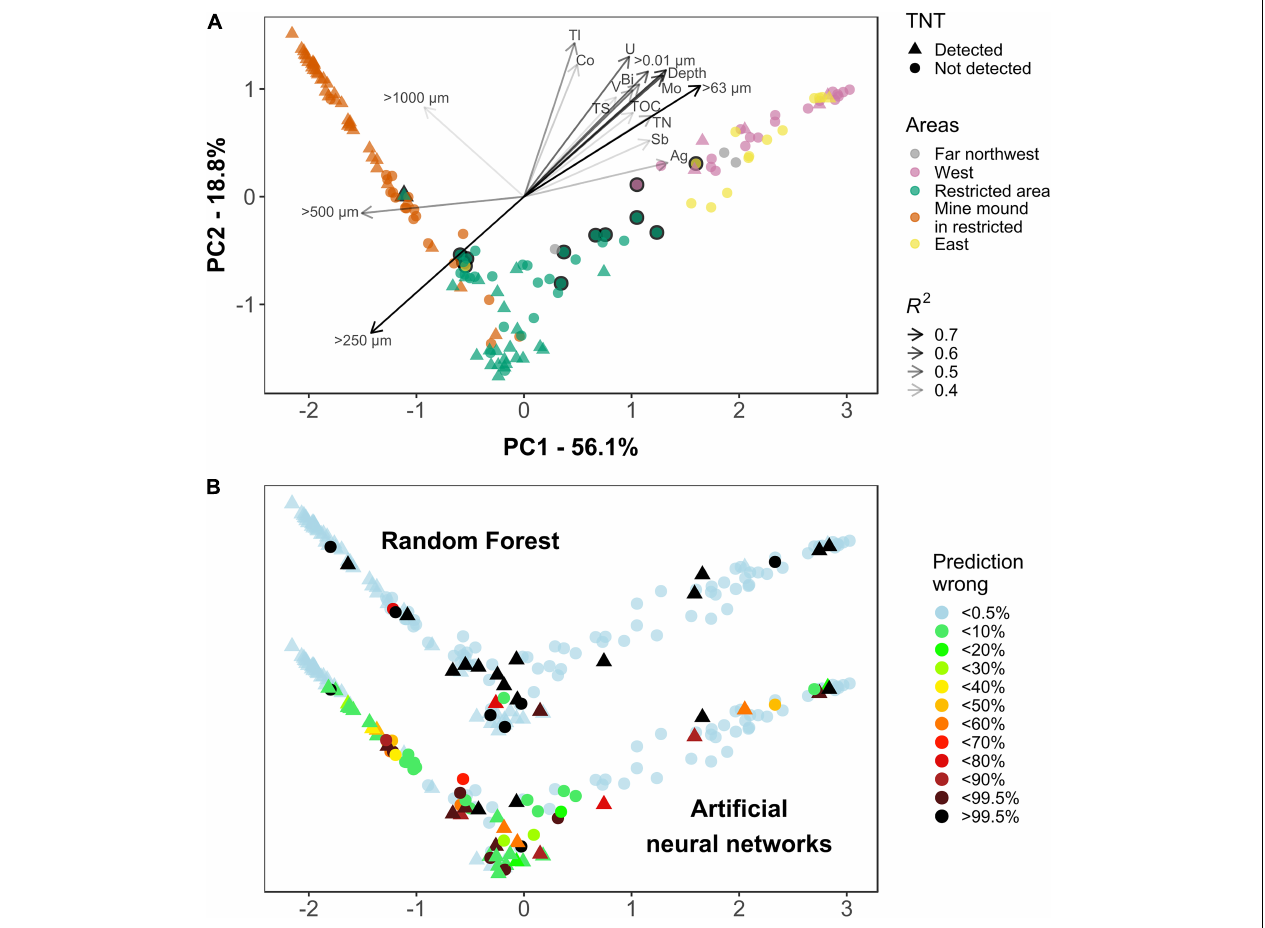
FIGURE 4 | Principal component analysis (PCA) ordination based on the abundance of the most important 25 genera. Dissimilarity between samples was calculated using the proximity matrix of an unsupervised random forest. (A) The microbial communities were colored by sample area and shaped to indicate the presence of TNT. The length and shade of correlating sediment parameters ( p < 0.001, R 2 > 0.3) represents the goodness of fit. The black outline marks East (yellow) and West (purple) samples which were not multicorer samples. Similarly, the outline marks Restricted Area samples that were not part of a transect. (B) Using the same ordination as in panel (A) , the fraction of misclassifications per 1,000 (RF, top) and 999 (ANN, bottom) predictions is displayed for each sample. Light blue colored samples were always correctly predicted, black displays consistently misclassified samples. Please note: the y -axis [PC2 in panel (A) ] was stretched to accommodate the results from both